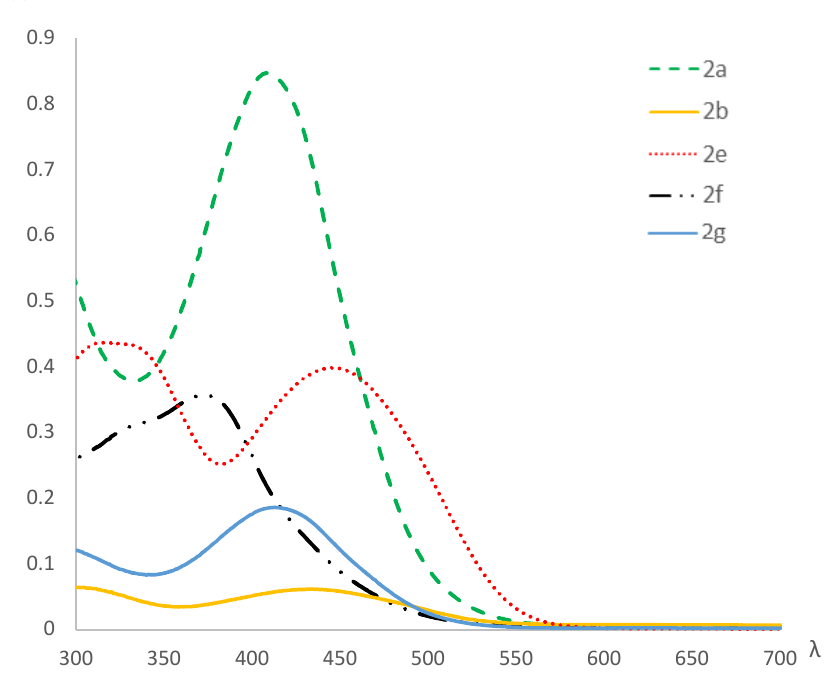
Figure 3. UV/VIS spectra of compounds ( 2a , 2b , 2e–2g ).